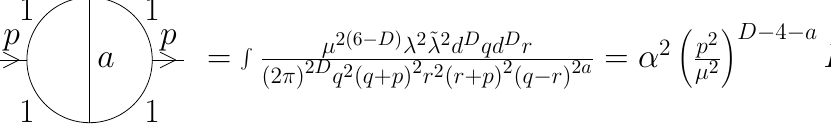
(cid:0) (cid:1) (cid:0) 2 power coming from the external p 2